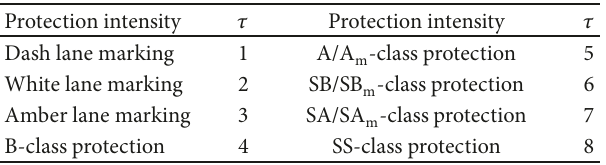
Table 4: The level of characteristic parameter of continuous field